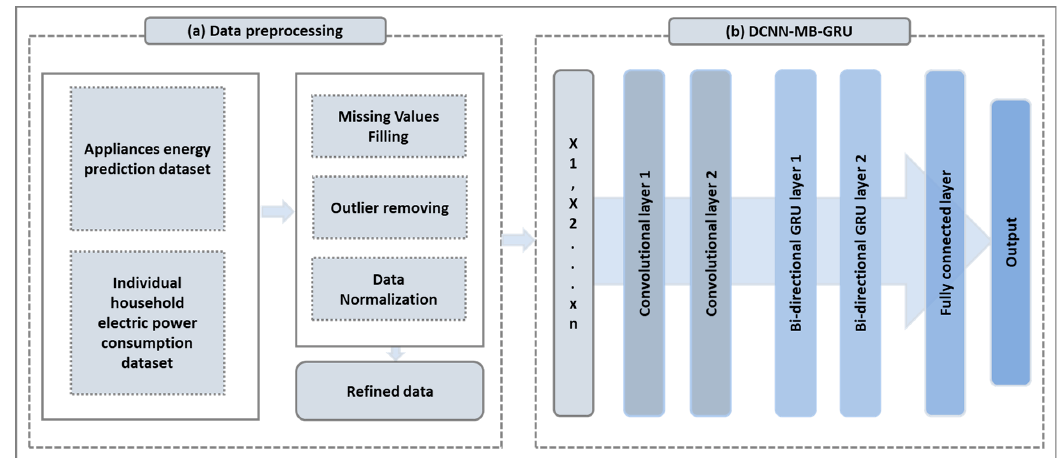
Figure 1. Two steps framework for electricity load prediction. ( a ) Applying different preprocessing techniques to refine the input raw dataset. ( b ) The proposed convolutional neural network (CNN)- multilayer bidirectional (MB)-gated recurrent unit (GRU) architecture to learn the patterns of electricity consumption.